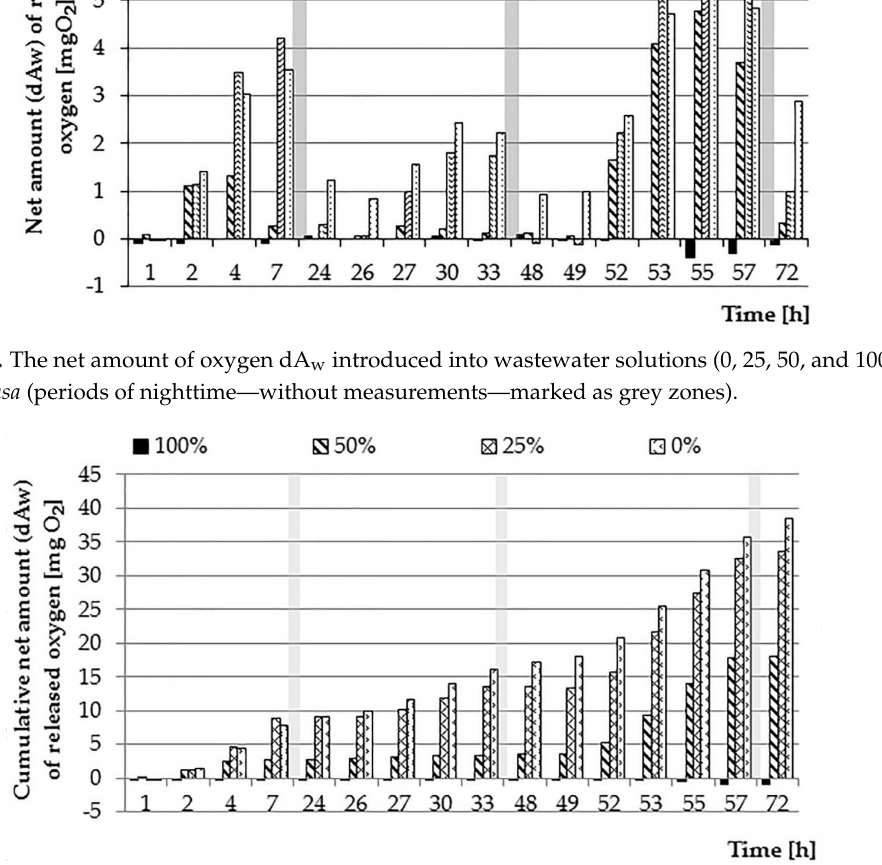
Figure 6. The net cumulative amount of oxygen dA w introduced into wastewater solutions (0, 25, 50, and 100%) by E. densa (periods of nighttime—without measurements—marked as grey